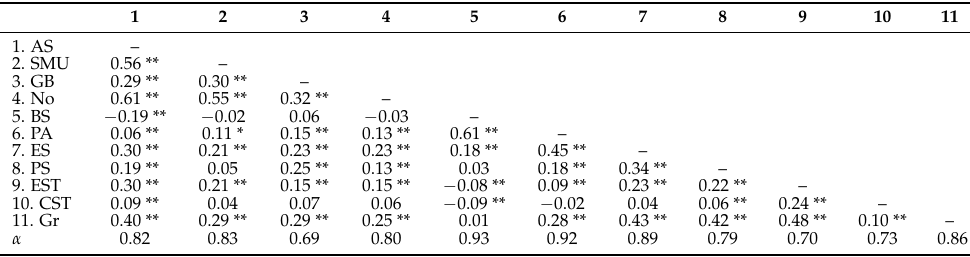
Table 2. Reliability coefficients and correlations between